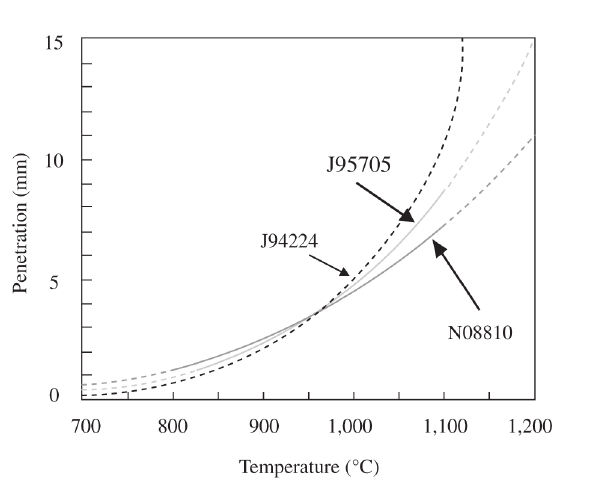
Figure 7. Effect of H Extent of Sulfidation/Oxidation of Several Alloys at 700 °C in H H S-H O Gases, after one 2 2